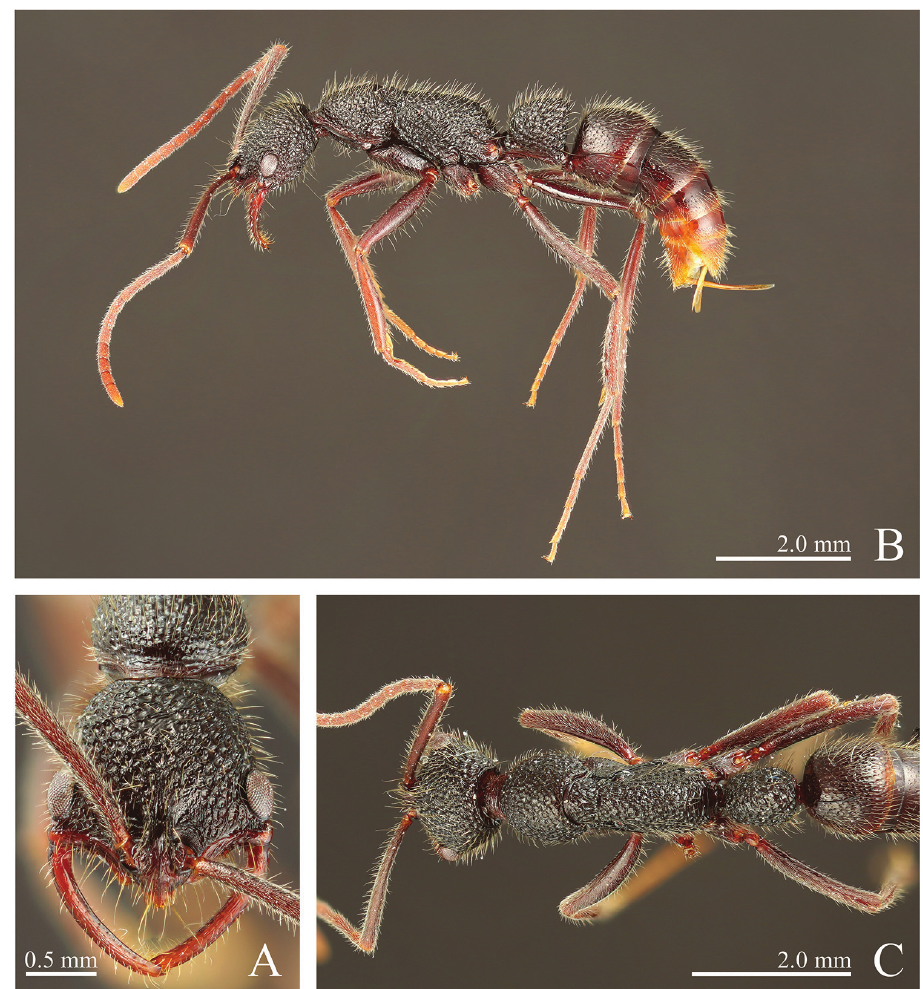
Figure 13. Leptogenys malayana sp. n., holotype, worker. A head, full-face view B lateral view C dorsal view.